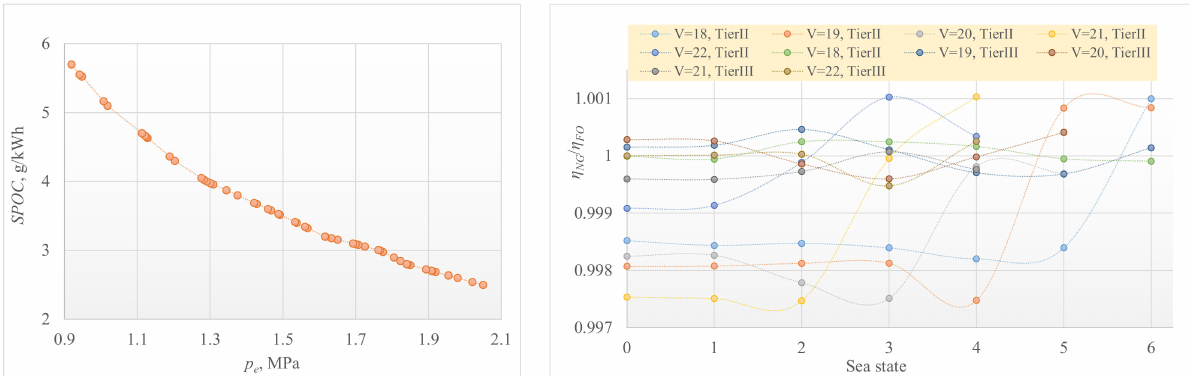
Figure 13. SPOC ( left ) and efficiency ratio ( right ) for NG and FO (Tier II and Tier III).